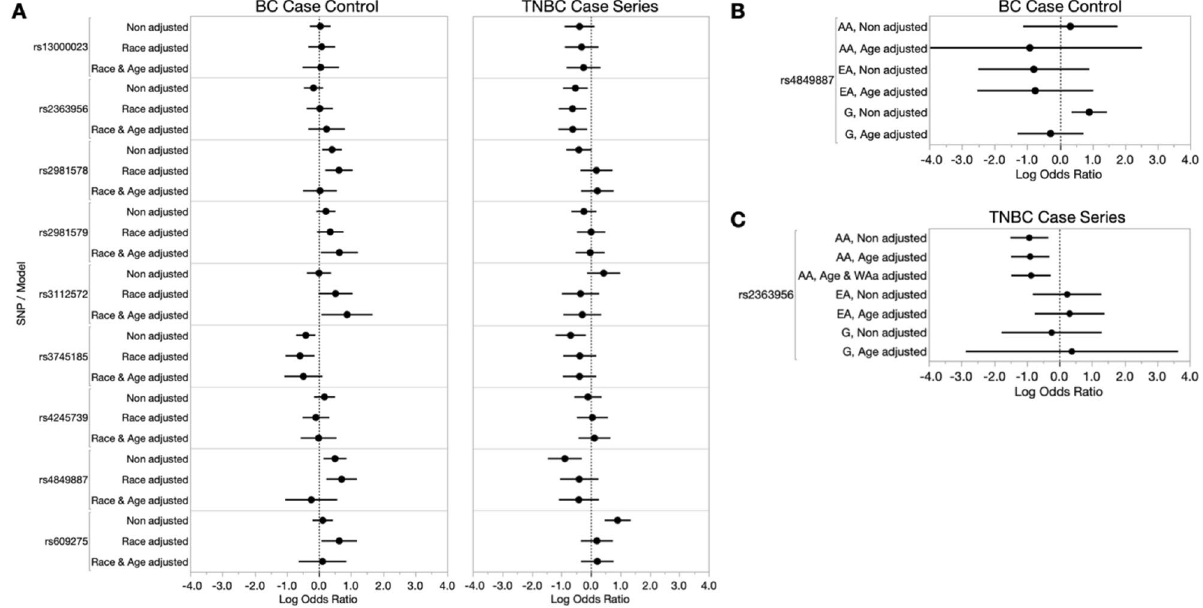
Figure 1. Breast cancer case–control and TNBC case-series risk analysis of previously identified BC risk alleles among our ICSBCS cohort. ( A ) The log odds ratio (x-axis) depicting SNV association with BC- or TNBC-risk among all samples is shown in non-adjusted models, and models adjusted for covariates (race and age) in our BC case–control analysis (left) and TNBC case-series analysis (right). ( B ) Within SIR BC case–control risk analysis for rs4849887. ( C ) Within SIR TNBC case-series analysis for rs2363956. For both ( B ) and ( C ), non-adjusted and age-adjusted models within SIR groups are shown for African Americans (AA),